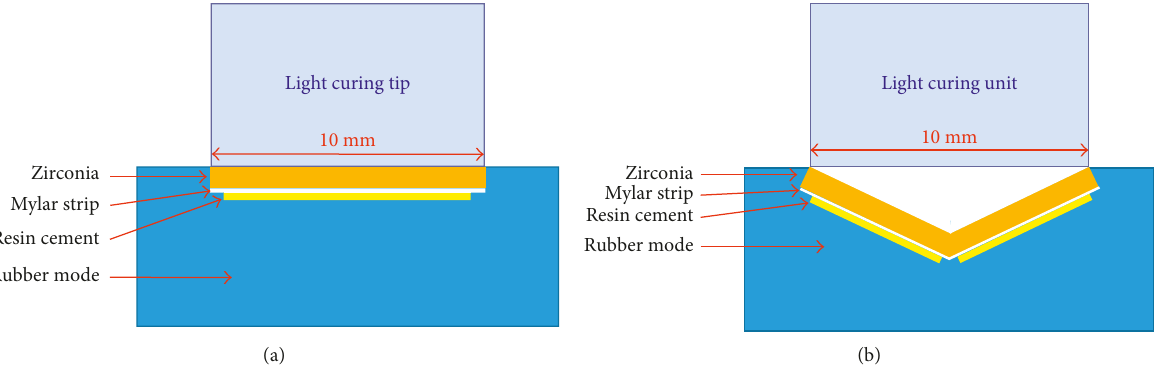
Figure 2: The light polymerization procedure of the resin cement under zirconia of (a) 0 ° cusp inclination and (b) 20 ° or 30 ° cusp inclination. Table 3: The mean and standard deviation of VH and DC values for the tested groups.